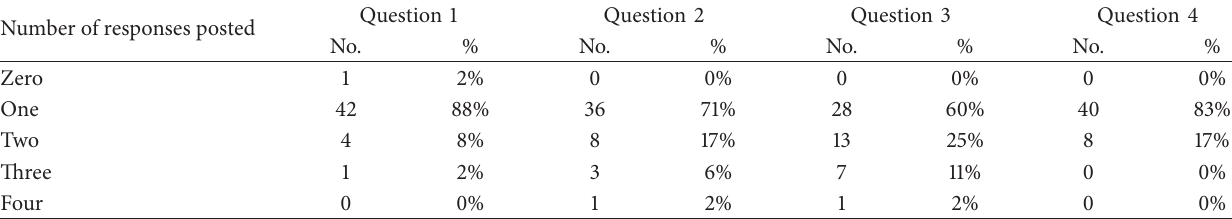
Table 2: Number of responses posted by student.